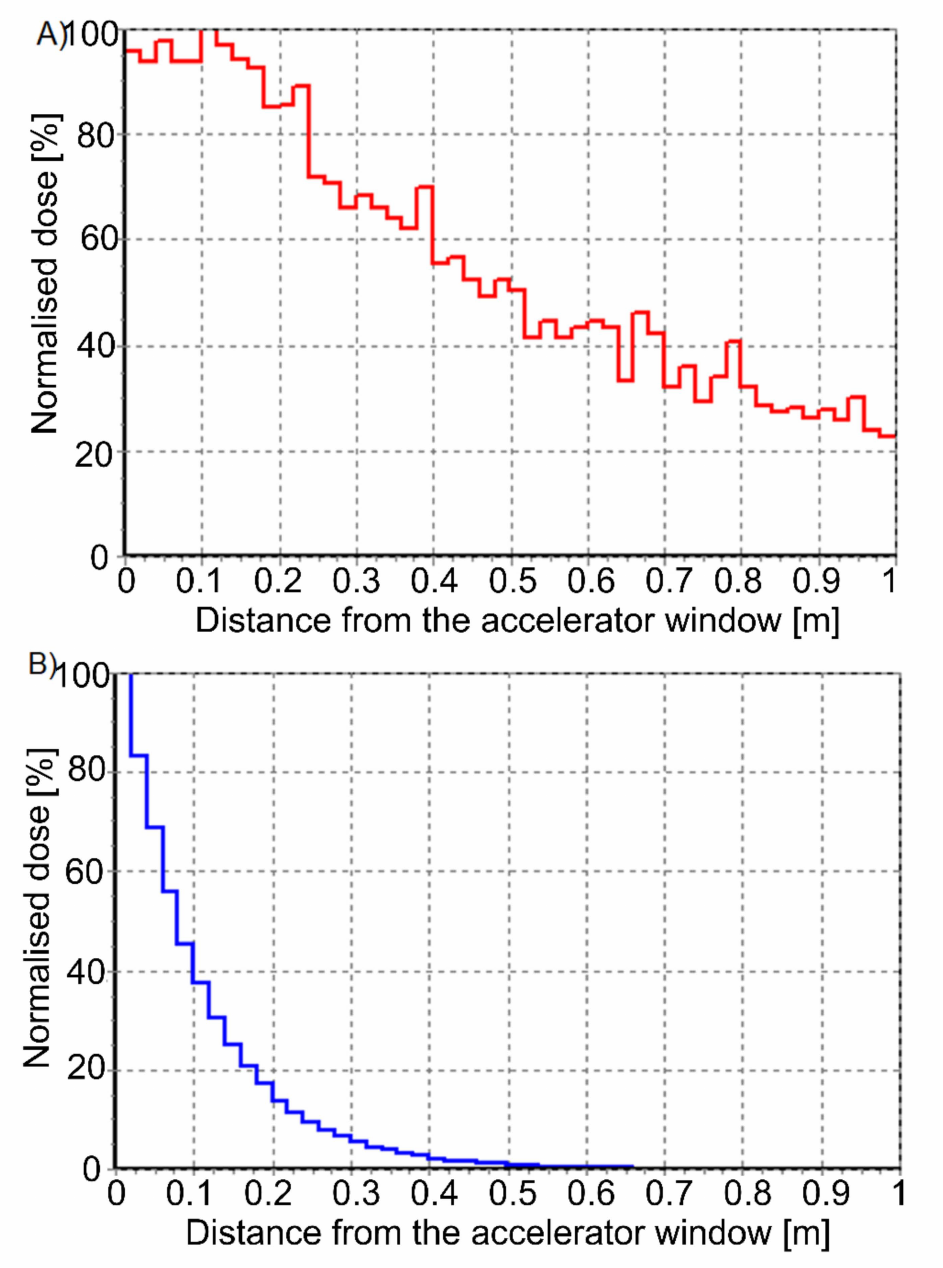
Figure 5. Energy deposition in: ( A ) air and ( B ) water of bremsstrahlung radiation generated by electrons of energy 930 keV in 5 mm thick water